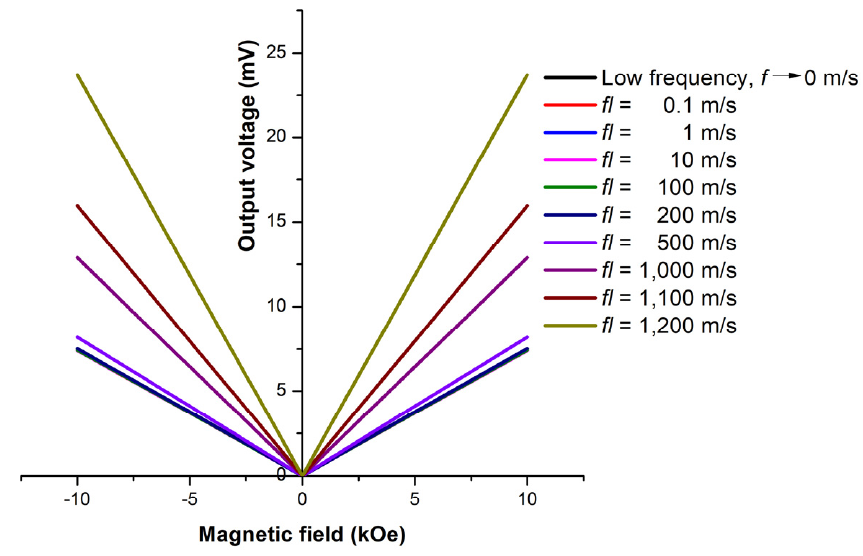
Figure 7. The readback voltage as a function of external magnetic field for fl = 0.1–1200 m/s. To mitigate this concern, the natural coupling between FM and AFM characteristic producing the exchange bias effect was applied to the ME sensor. PtMn and Cr 2 O 3 were selected as the AFM materials to be coupled with Terfenol–D, the FM material. The exchange bias effect was simulated using MuMax 3 simulation and observed through the FM hysteresis loop. The demonstration of the ME sensor as the hard disk drive (HDD) read head sensor was assumed; therefore, the FM/AFM—was set up with the maximum width of 36 nm, double the bit length at 2 Tb/in 2 [11]. The structure length varied between 938, 400, and 200 nm, conforming with the optimal operating frequencies of 1.28 GHz, 3 GHz, and 6 GHz, respectively, of the current commercial TMR hard disk drives. Note that the first is the typical operating frequency while the latter two are the maximum operating frequencies of SATA II and SATA III standards, respectively [32]. Note also that the optimal frequencies satisfy fl = 1200 m/s. Since the force interaction is symmetrical due to Newton’s third law, the saturation magnetization in the AFM layer was deemed equal to that of the FM layer [24]. In addition, since the exchange stiffness of Cr 2 O 3 was not found in FeMn